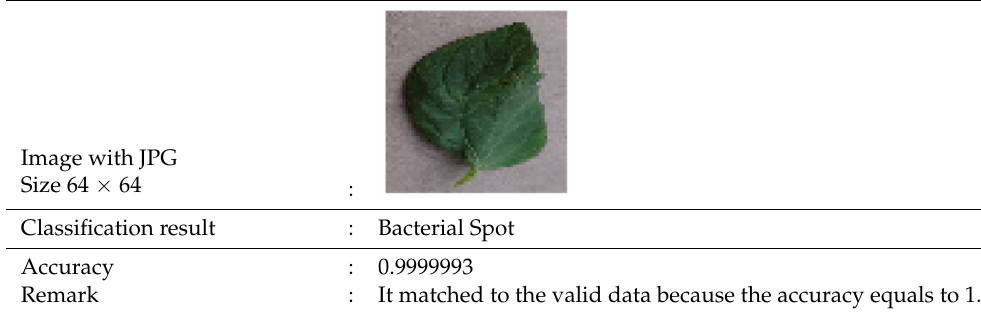
Table 4. Some parts of the test results were outputted from the built application by using the valid dataset